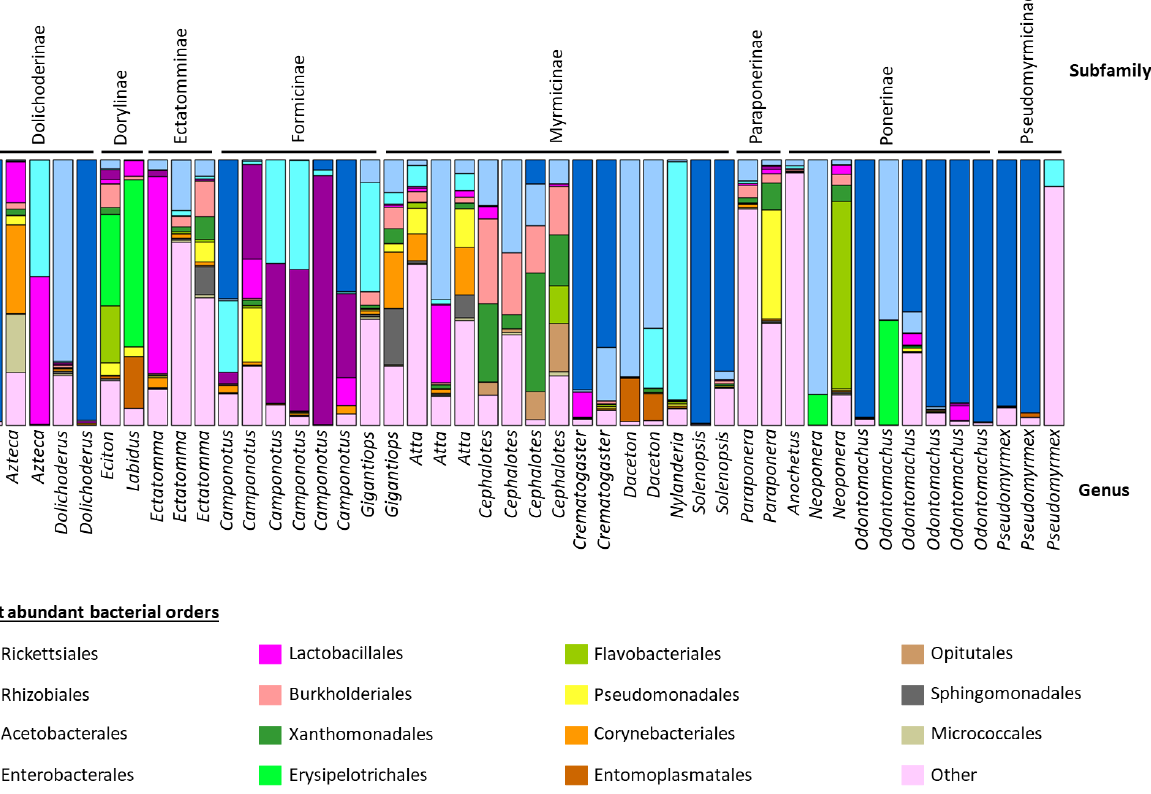
Figure 1. Taxa bar plot based on the relative abundance classified by ant subfamily and genus. Relative abundance bars are colored by bacterial order percentage. Only the 15 most abundant bacterial order associated with Amazonian ants are listed. The less abundant bacterial orders are grouped under the term “Other”.